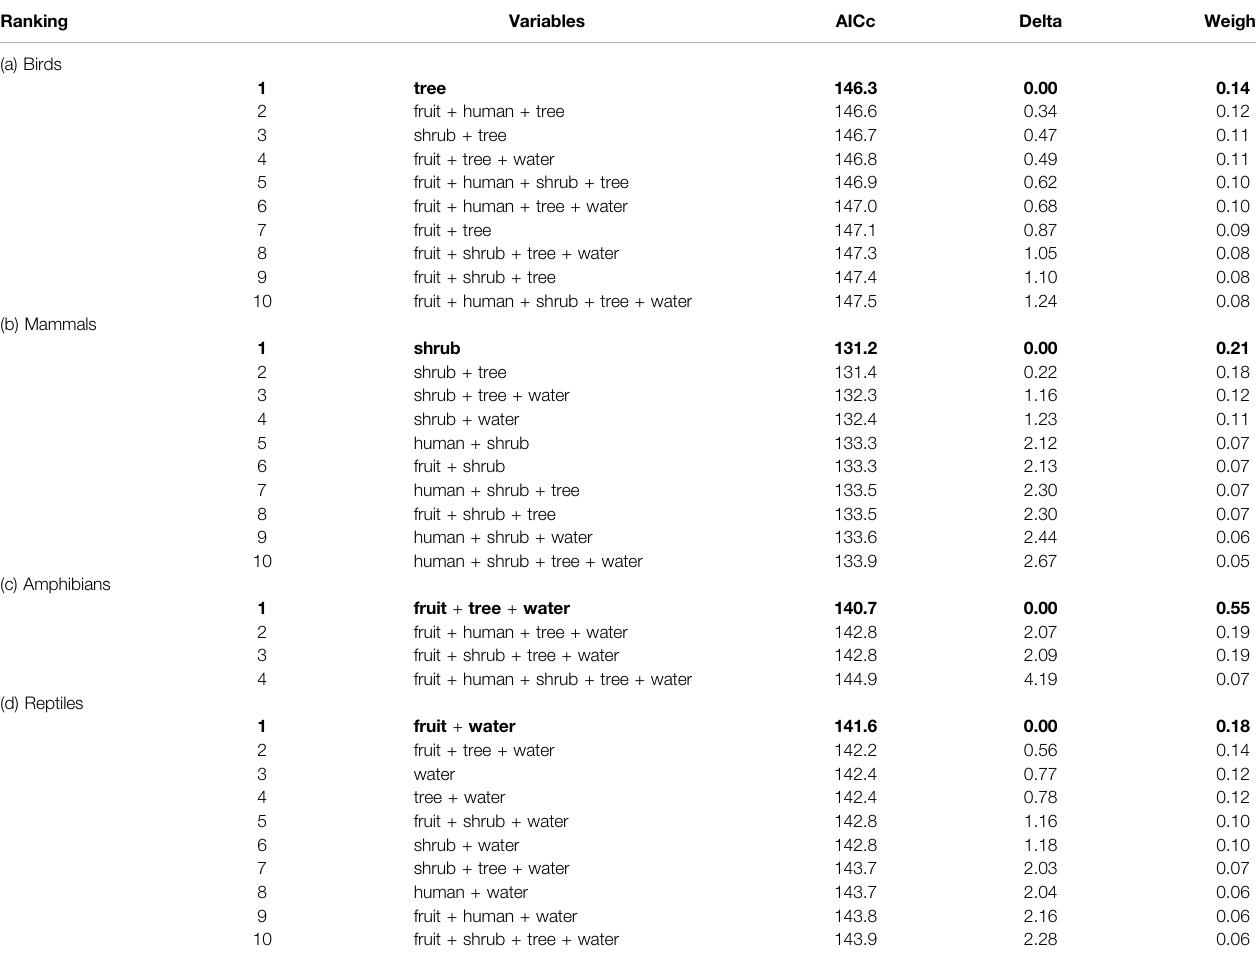
TABLE 3 | Ranking of the best statistical models which were retained in each con fi dence set, where the Akaike's difference (Delta) with the top-ranked model was less than 5.0,followingtheInformationTheoreticapproach,for(a)birds,(b)mammals,(c)amphibians,and(d)reptiles.Themostparsimoniousmodelsareinbold.Weightrefersto the cumulative weight of the models starting from the top ranked model. Bold values signi fi es “ The most parsimonious models ” .